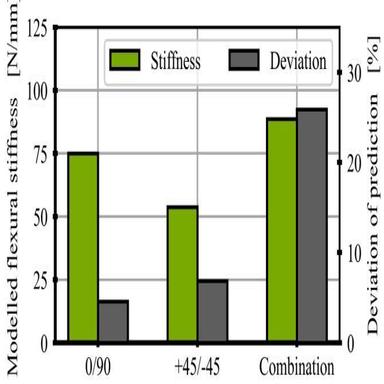
Analytically modelled flexural stiffness and the deviation to the experimental results on 2D plate without considering the manufacturing process variation.